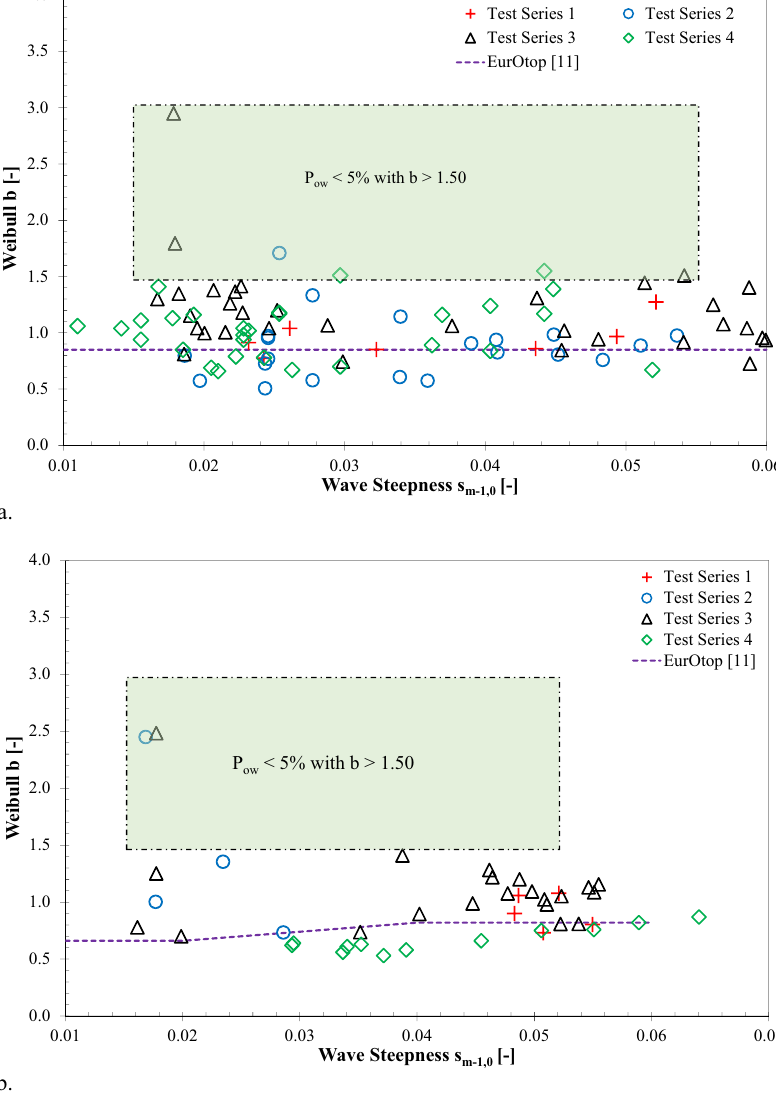
Figure 9 analyses the measured Weibull shape parameter as a function of relative discharge q/ (g H m0 T m-1,0 ). The Weibull b values for the vertical walls tested in VOWS project are presented in Fig. 9. The dashed lines signify the empirical predictions made by Zanuttigh et al. 26 for smooth and rubble mound structures. For impulsive wave conditions, the measured Weibull b values are slightly higher than that of empirical predictions see Eq. (8) reported by 26 . Figure 9 (a) highlights the conservative approach of Eq. (8) for prediction of the shape parameter for vertical breakwaters. Upon adopting the methodology prescribed by 26 , a new and improved trend for plain vertical walls is proposed in this study using the data retrieved from measured Weibull b values and the VOWS project see Eq. (16). The scatter data points that corresponded to low overtopping waves (below 5%) and higher Weibull b values were excluded from Eq. (16).